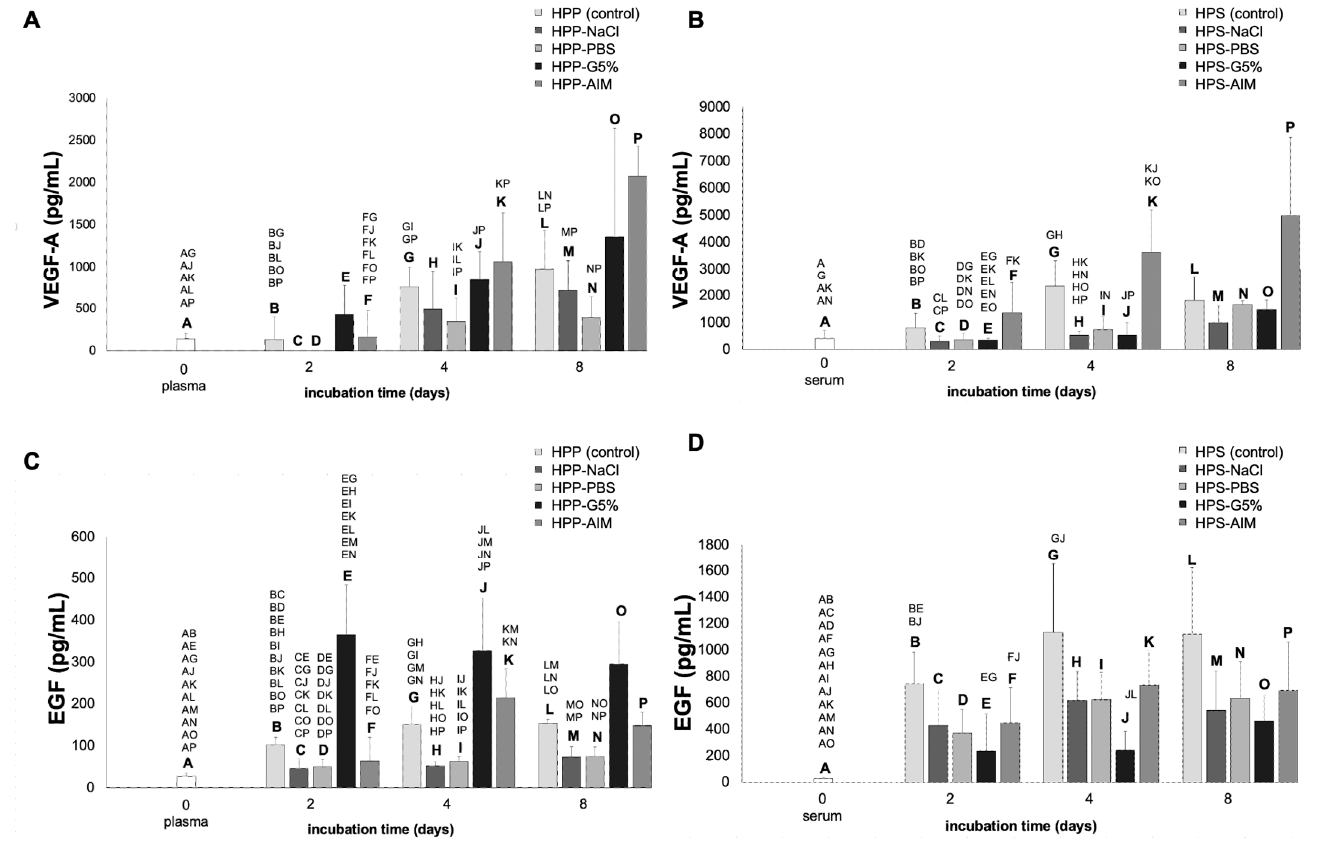
Figure 2. Quantitative analysis of pro-angiogenic growth factor (VEGF-A, EGF) concentration in various hypoxia preconditioned media. Plots showing the concentration of VEGF-A (pg/mL) ( A , B ) and EGF (pg/mL) ( C , D ) in fresh plasma and serum, as well as in hypoxia preconditioned plasma (HPP) and serum (HPS) and four different hypoxia preconditioned media substitutes: hypoxia preconditioned normal saline (HPP/HPS-NaCl), hypoxia preconditioned phosphate buffered saline (HPP/HPS-PBS), hypoxia preconditioned Glucose 5% (HPP/HPS-G5%), and hypoxia preconditioned AIM V medium (HPP/HPS-AIM), incubated for 2, 4, and 8 days. Blood donors: n = 4. Two-way repeated measures ANOVA with Tukey’s multiple comparison test. Data points are means ± SD. Capital letter pairs over plots indicate statistical comparison of corresponding data points. For all pair comparisons, p < 0.05.